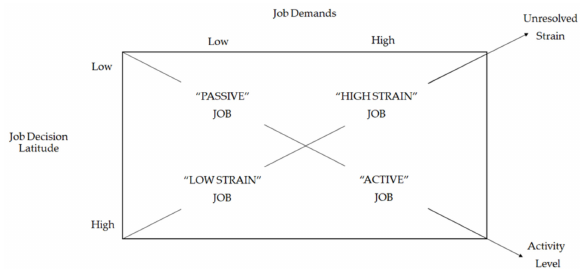
Figure 1. Job Demands-Control Model [18] (p.